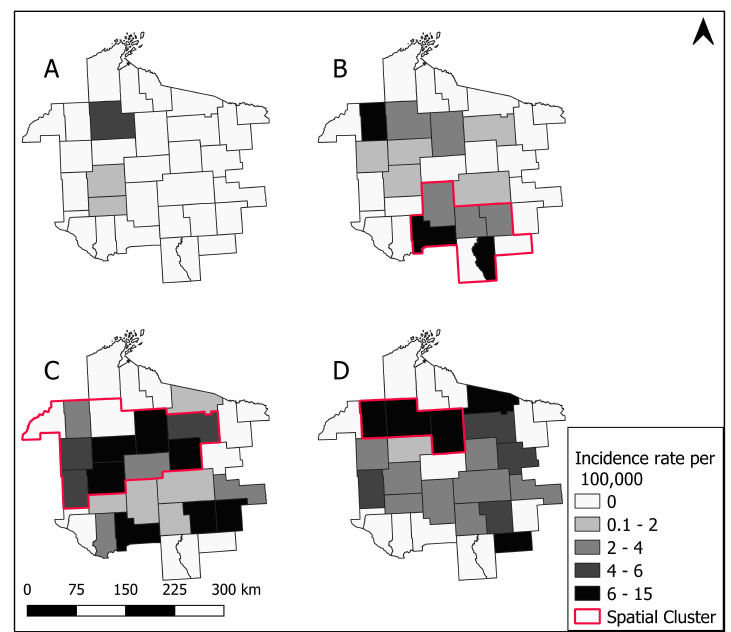
Figure 7. County level incidence of positive laboratory cases of babesiosis per 100,000 patients from time periods of ( A ) 2000–2003, ( B ) 2004–2007, ( C ) 2008–2011, ( D ) 2012–2016 in the Marshfield Clinic Health System. The respective primary spatial clusters are outlined in